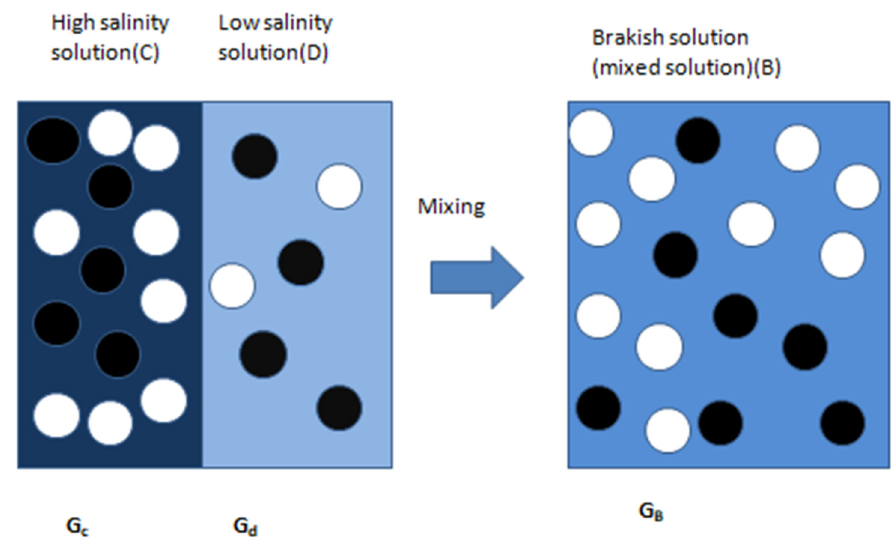
Figure 17. The combination of a concentrated and diluted solution to a brackish solution.